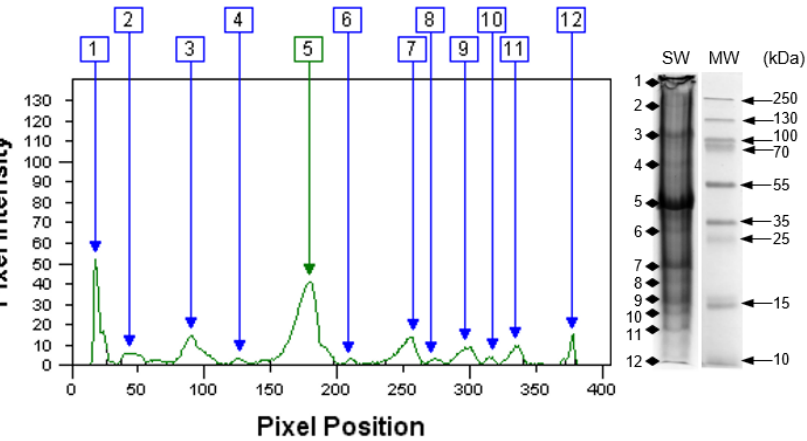
Figure 3. Electrophoretic profile of proteins S. woodiana (SW) mussel powder. 1–12 bands of proteins. MW—molecular weight of protein (kDa) standard. Table 4. Molecular weight and percentage share of the protein bands marked in S. woodiana mussel powder.